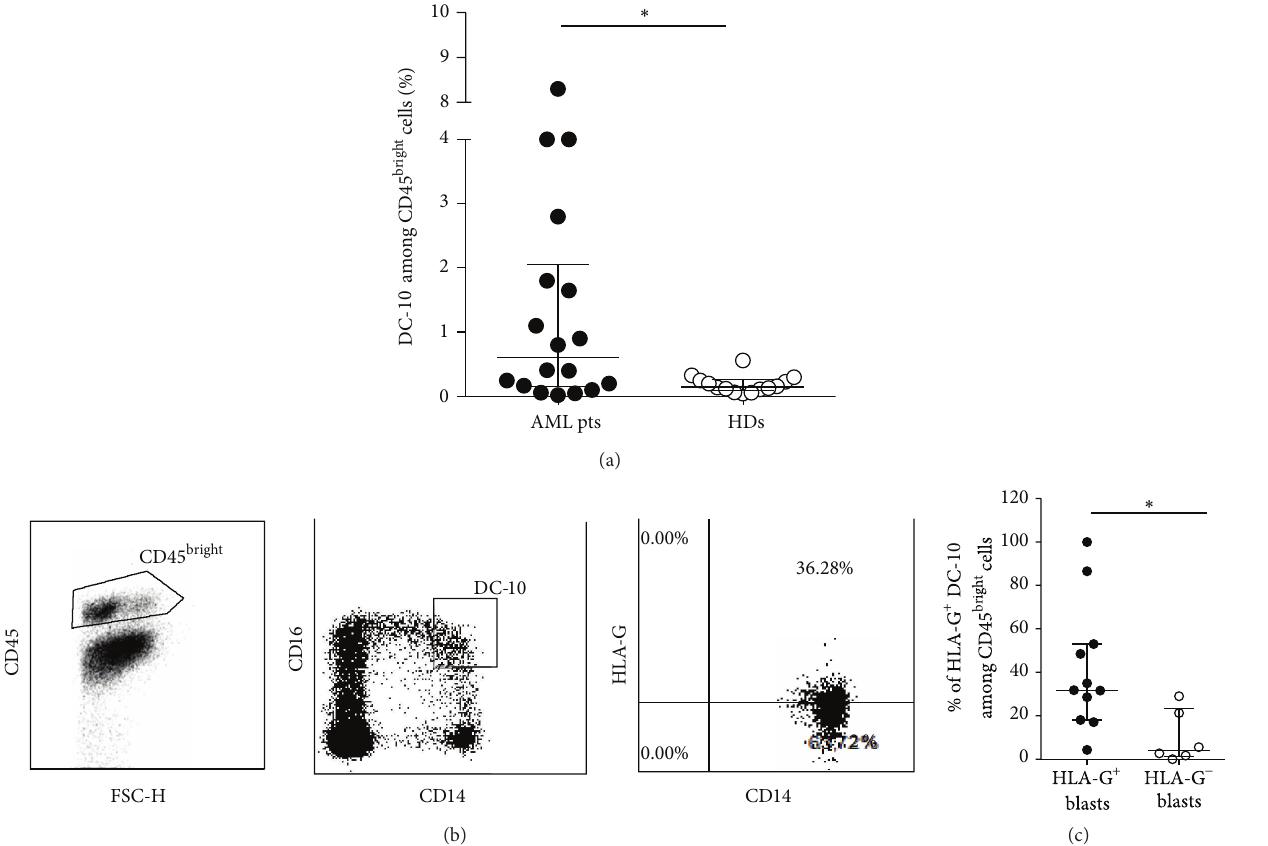
Figure 2: Flow cytometric analysis of cells containing DC-10 in the peripheral blood of AML patients. (a) Percentages of DC-10, identified among the CD 45 bright cells according to the co-expression of CD14 and CD16, in the peripheral blood of AML patients (AML pts) and healthy donors (HDs) are shown. Each dot represents single AML patient or HD. Lines indicate median and interquartile range of positive cells detected in all patients and donors analyzed. ∗ 𝑃 < 0.05 . (b) Representative dot plots of HLA-G + DC-10 are depicted. (c) Percentages of HLA- G + DC-10 in patients with HLA-G + or HLA-G − blasts are shown. Each dot represents single AML patient. Lines indicate the median and interquartile range of HLA-G + DC-10. ∗ 𝑃 < 0.05 .